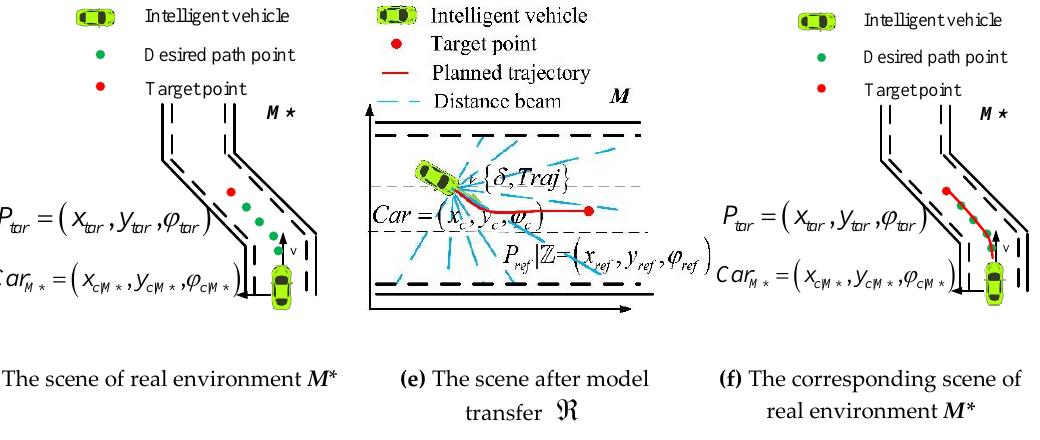
Figure 5. Transition diagram of the switch task model.